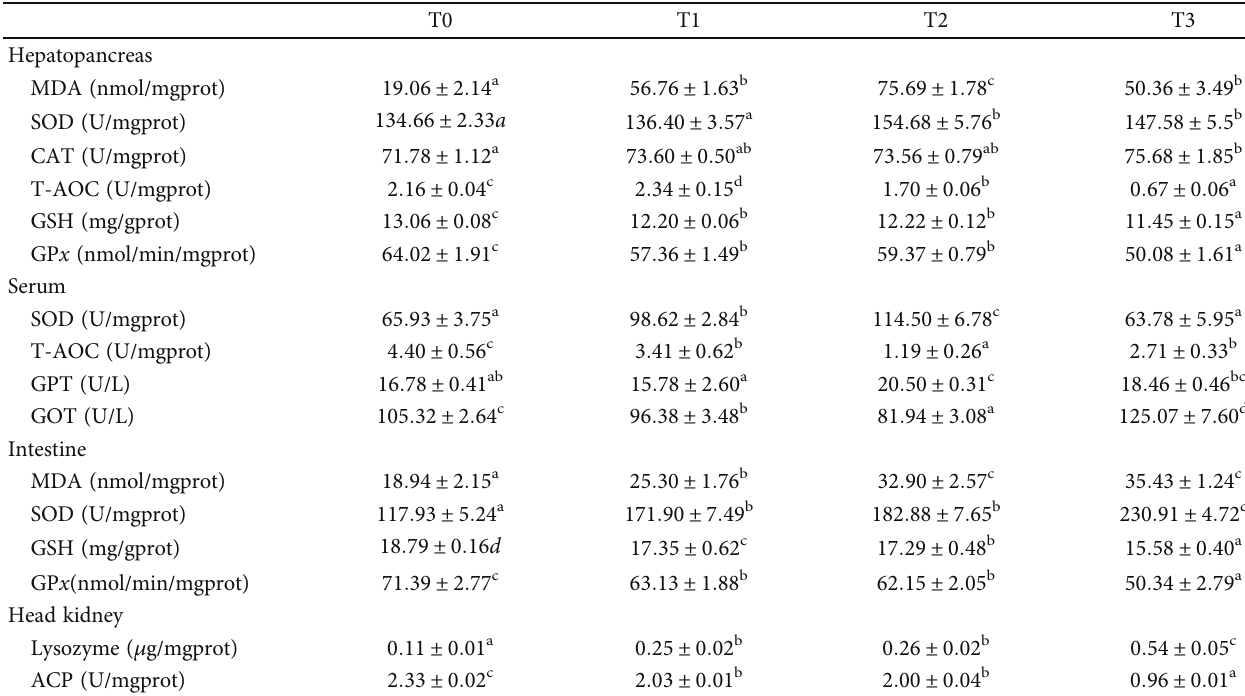
Table 6: Biochemical and immune parameters in di ff erent tissues of grass carp fed semipuri fi ed diets ( means ± SD , n = 3 ). T0 T1